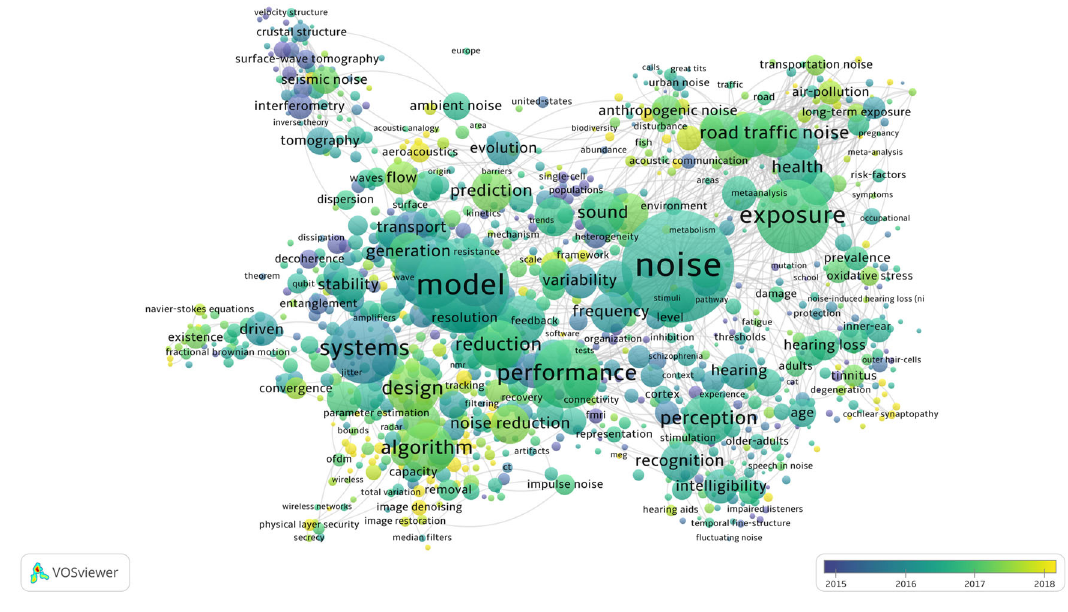
Fig. 1 Visualization of research hotspots.